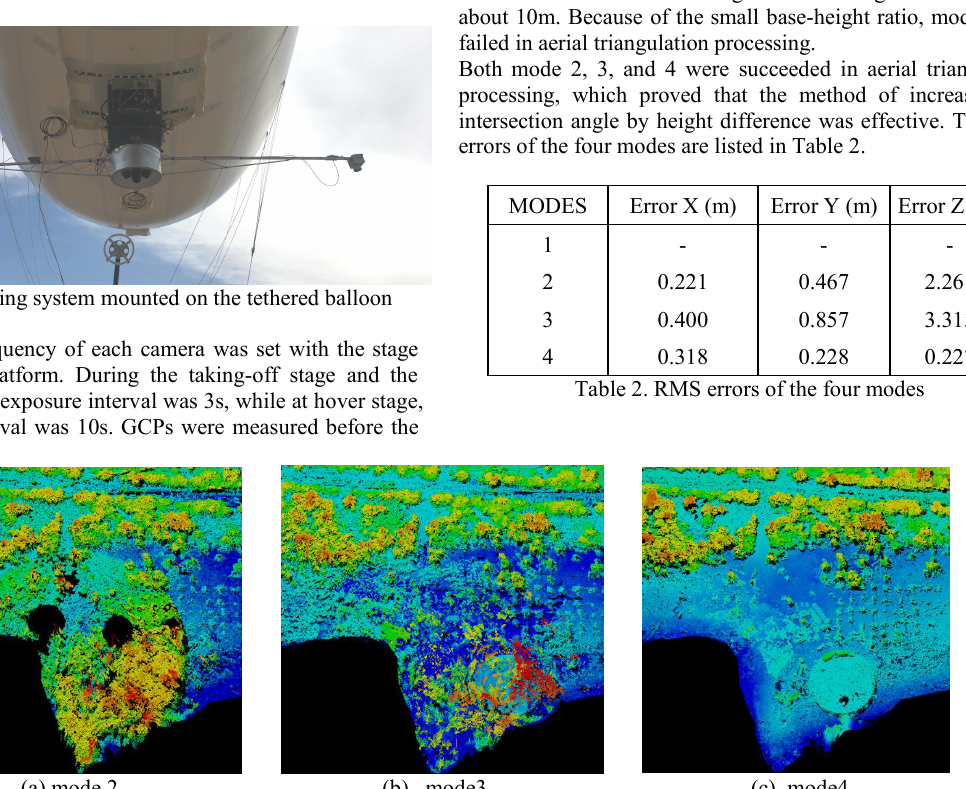
Figure 5.Point cloud produced by different modes(colored by elevation). (a)The point cloud is obviously wrong of mode 2. (b)There